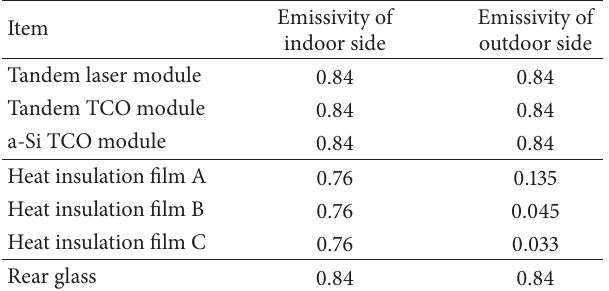
Table 2: Emissivity of each component.